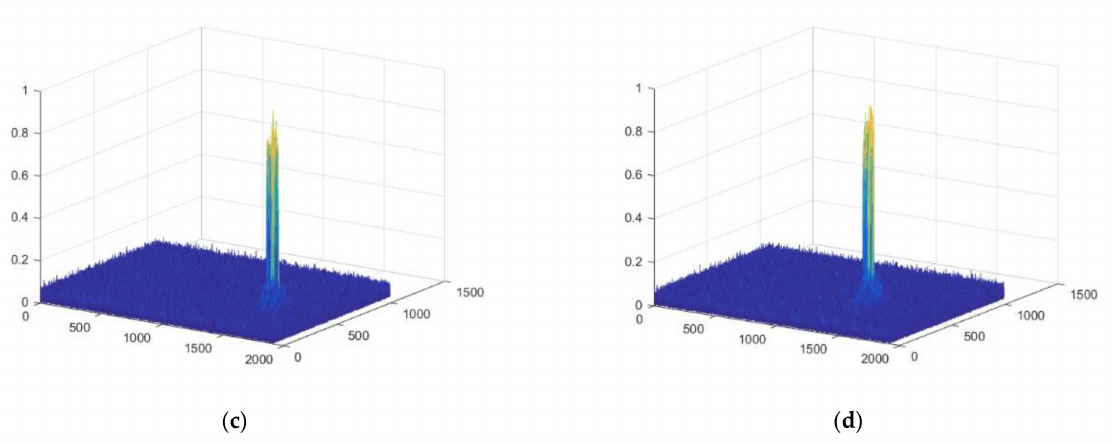
Figure 14. Side view analysis results ( a ) without phase-locked algorithm and ( b – d ) with phase- locked